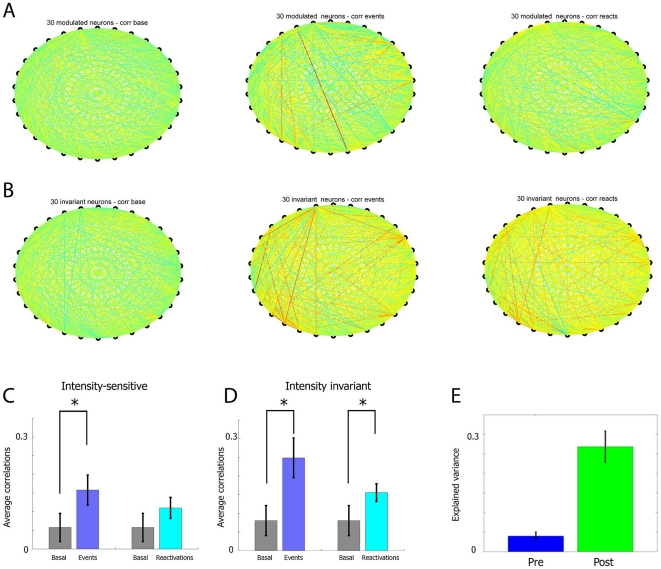
Correlations among intensity-sensitive and intensity-invariant
neurons during basal, event and reactivation time periods.(A) Basal states correlation coefficient among 30 top
neurons belonging to specific, subgeneral and general
intensity-sensitive units (each category contains 10 cells) are
displayed as colored lines that unite these 30 unit (left panel). Bluer
colors indicate negative correlations and redder colors indicate
positive correlations. While a significant number of units are more
correlated during startle events (middle panel), these correlations
mainly return back to basal values during reactivation time periods
(right panel). (B) In contrast, for intensity-invariant
neurons (10 for each of the specific, subgeneral and general categories,
for a total of 30), although basal states are also characterized by low
value for the magnitude of correlation coefficients (left panel), and by
high values during the startle events (middle panel), these units remain
highly correlated during the reactivation time period (right panel).
(C) Statistics of the 254 pairs for intensity-sensitive
group, which have been obtained by eliminating the pairs that are very
weekly correlated during non-basal time periods (magnitude less than
0.05) are in agreement with the visual information displayed in A,
indicating that the values during event time period are significantly
different from the base levels, but the correlation levels during
reactivation are not. (D) In contrast statistical analysis
of the 315 pairs for the intensity-invariant group (obtained by
excluding the correlations that have a magnitude less than 0.1) indicate
that correlations are elevated during both events and time reactivation.
(E) Explained variance during the time period before
the stimuli and the time period after the stimuli have been delivered
also suggest that correlations among units remain at higher levels in
the post-stimuli time period, which is in agreement with the heightened
correlation among intensity-invariant neurons.